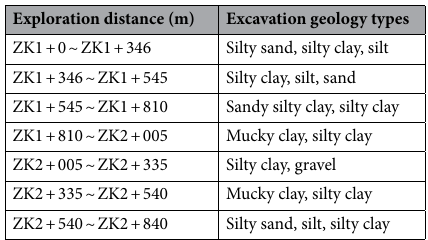
Table 1. Geological conditions of excavation strata.